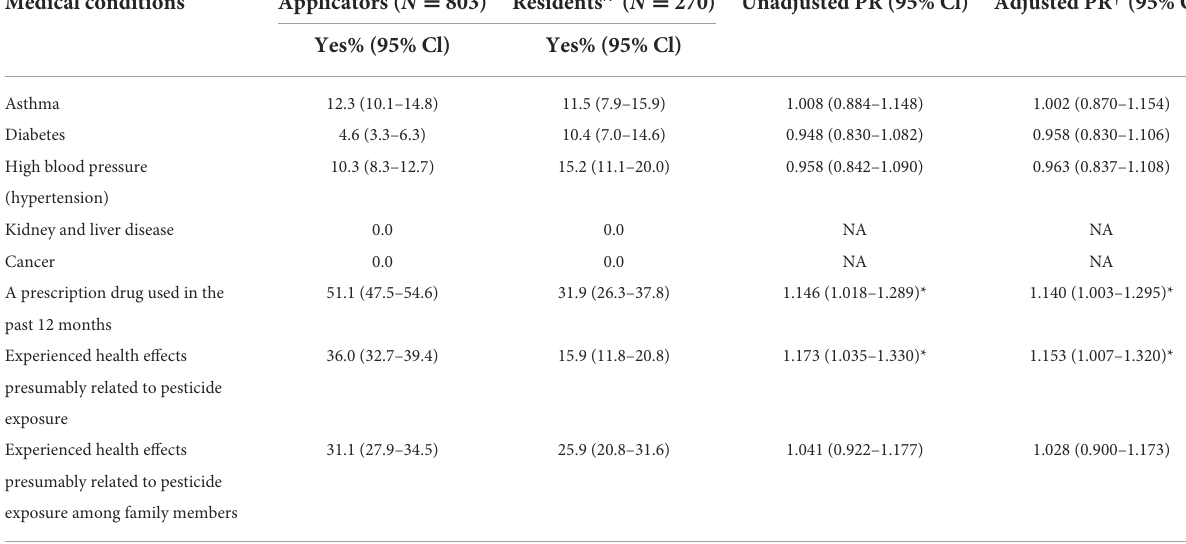
TABLE 6 Existing medical conditions and health effects presumably caused by pesticide exposure among applicators and residents in East Hararge Zone, Oromiya Region, Ethiopia.